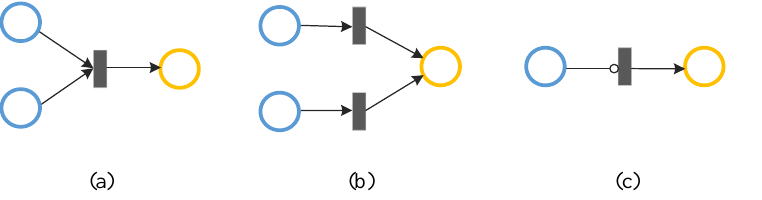
Figure 7. Petri net representation of logical “ with, or, or not ” : ( a ) logical “ with ” ; ( b ) logical “ or ” ; ( c ) logical “ not ” .